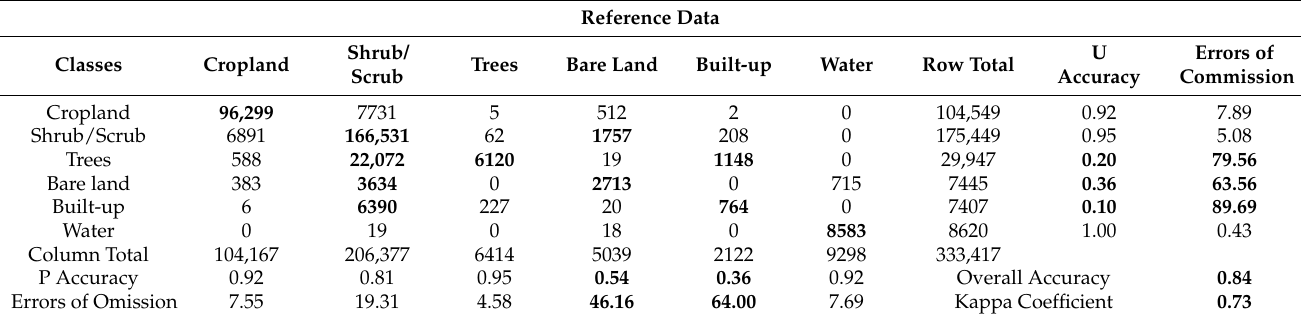
Table 2. Confusion matrix of the RF50